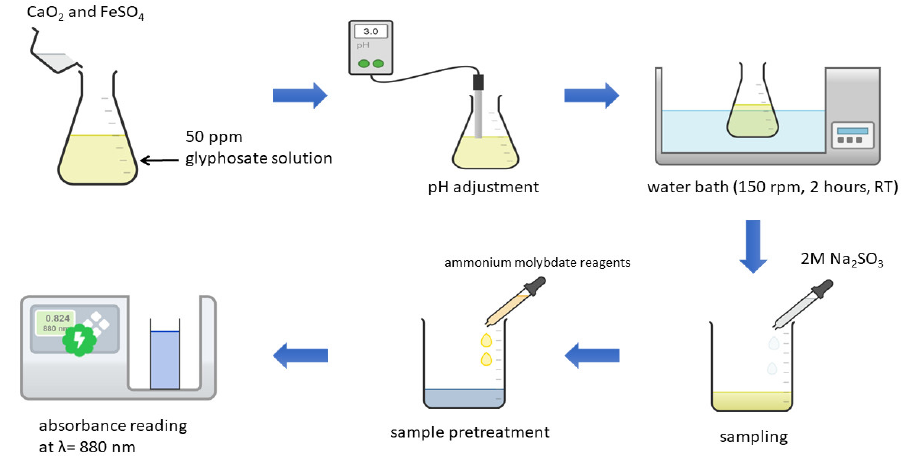
Figure 2. Schematic diagram of experiment process on glyphosate removal.